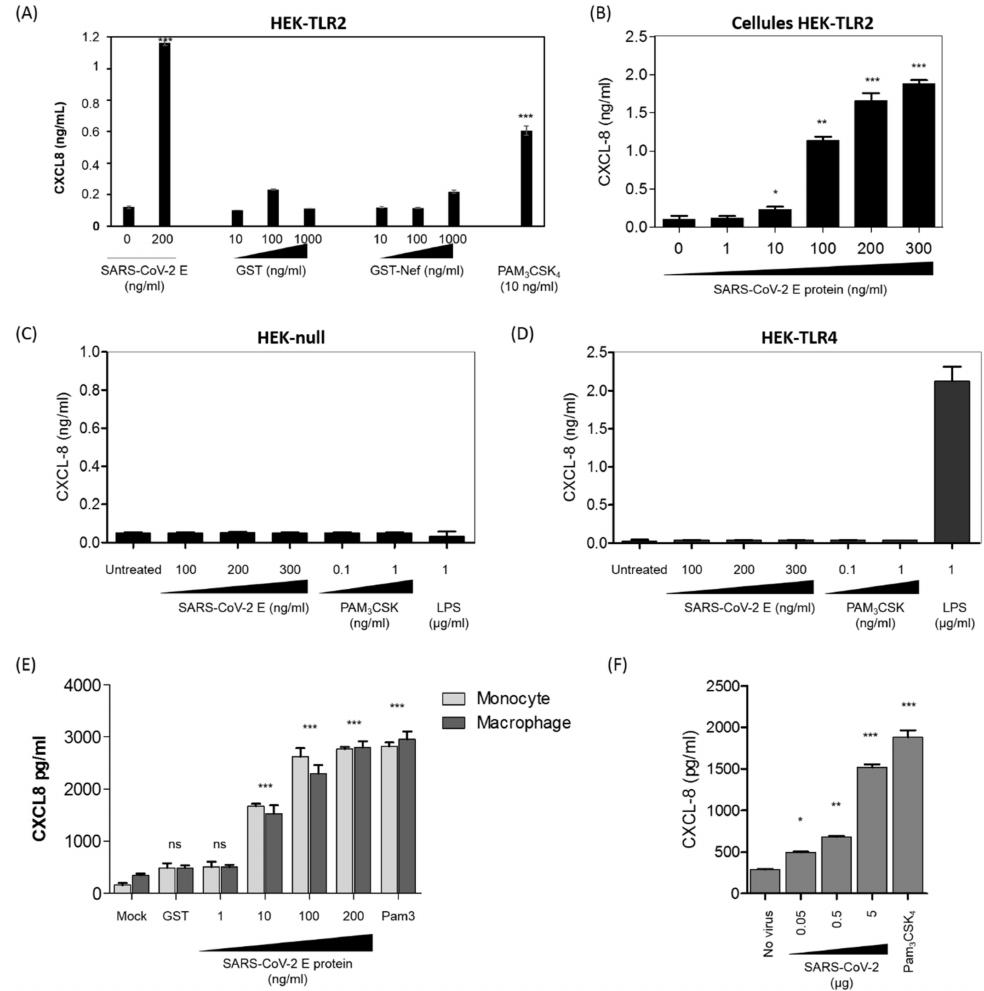
Figure 3. The E protein stimulates the production of the CXCL8 chemokine in a TLR2-dependent manner. ( A ) The HEK-TLR2 cell line was stimulated with the E protein (200 ng/mL), GST (10–1000 ng/mL), GST-Nef (10–1000 ng/mL) or PAM3CSK4 (10 ng/mL). CXCL8 chemokine pro- duction in the cell supernatants was quantified by ELISA. ( B ) Production of CXCL8 in cell super- natants of HEK-TLR2 cells stimulated by escalating concentrations of the E protein (1–300 ng/mL). ( C , D ) Production of CXCL8 in cell supernatants of HEK-null ( C ) and HEK-TLR4 ( D ) cell lines stim- ulated with the E protein (1–100 ng/mL) or with PAM3CSK4. ( E ) Primary human monocytes and macrophages were stimulated with the E protein (1–200 ng/mL). Stimulation with GST (200 ng/mL) or PAM3CSK4 (1000 ng/mL) was used as a negative and a positive control, respectively. After 20 h of treatment, the cell supernatant was collected and CXCL8 chemokine production in the cell supernatants was quantified by ELISA. ( F ) Primary human monocytes (10 6 ) were stimulated with an increasing amount (0.05 µ g/mL–5 µ g/mL—equivalent viral proteins present in the purified viral pel- let) of β -propiolactone-inactivated SARS-CoV-2. Stimulation with PAM3CSK4 was used as a positive control. After 20 h of treatment, the cell supernatant was collected and CXCL8 chemokine production in the cell supernatants was quantified by ELISA. Statistical significance comparing different groups is denoted with * for p < 0.05, ** for p < 0.01 and *** for p < 0.001, while ns means